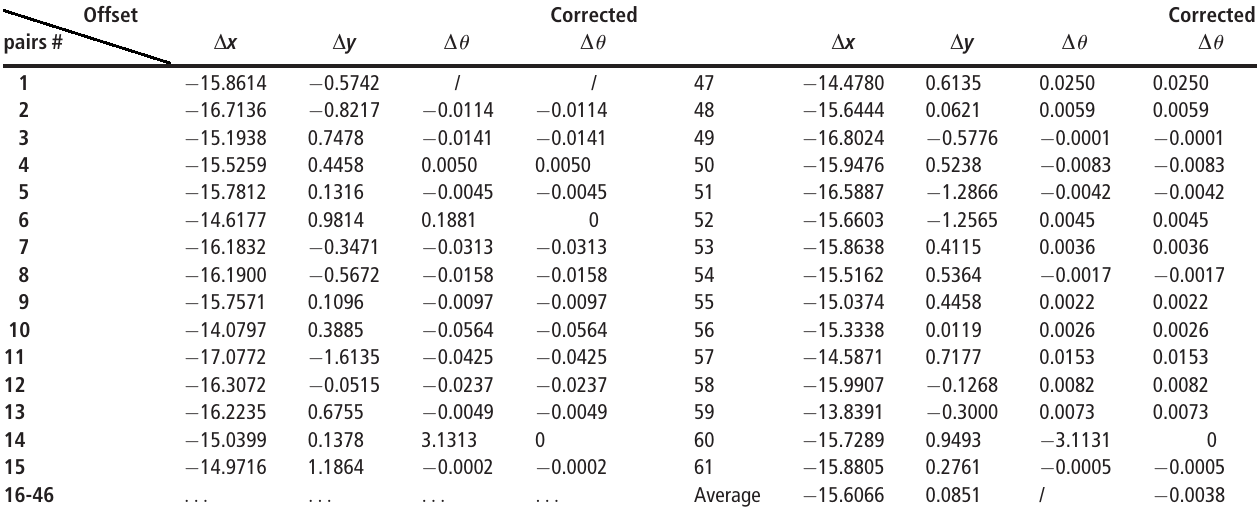
Table 2 The offsets of all matched pairs between two images